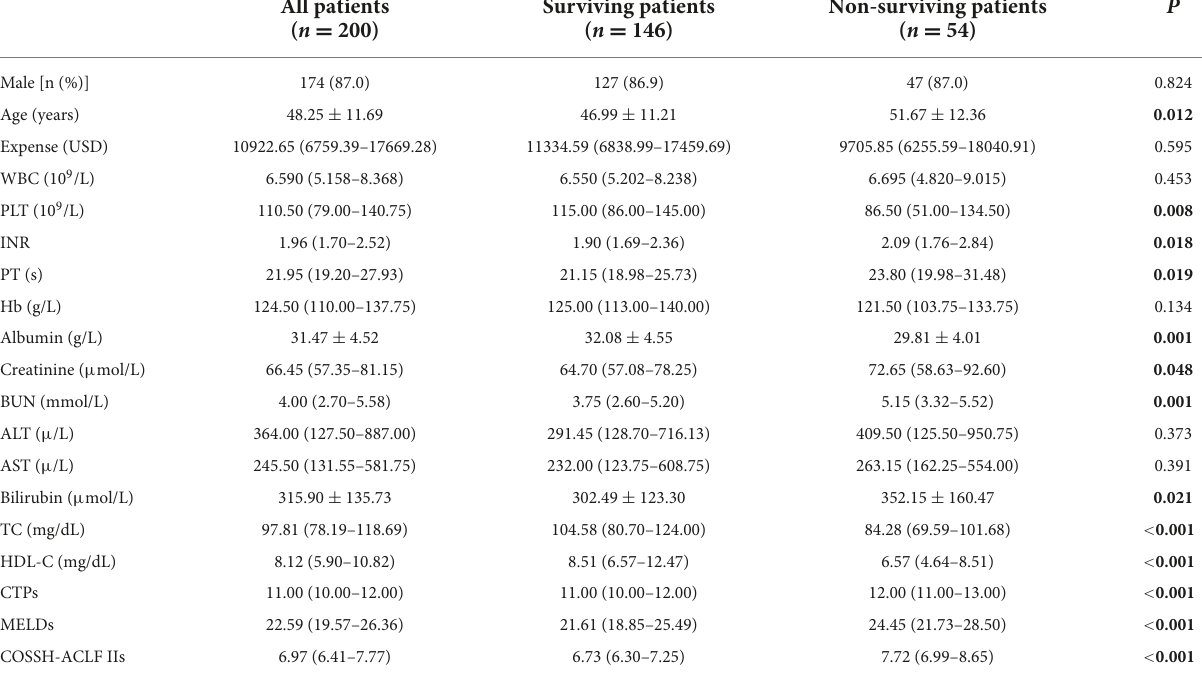
TABLE 1 Baseline characteristics of HBV-ACLF patients.